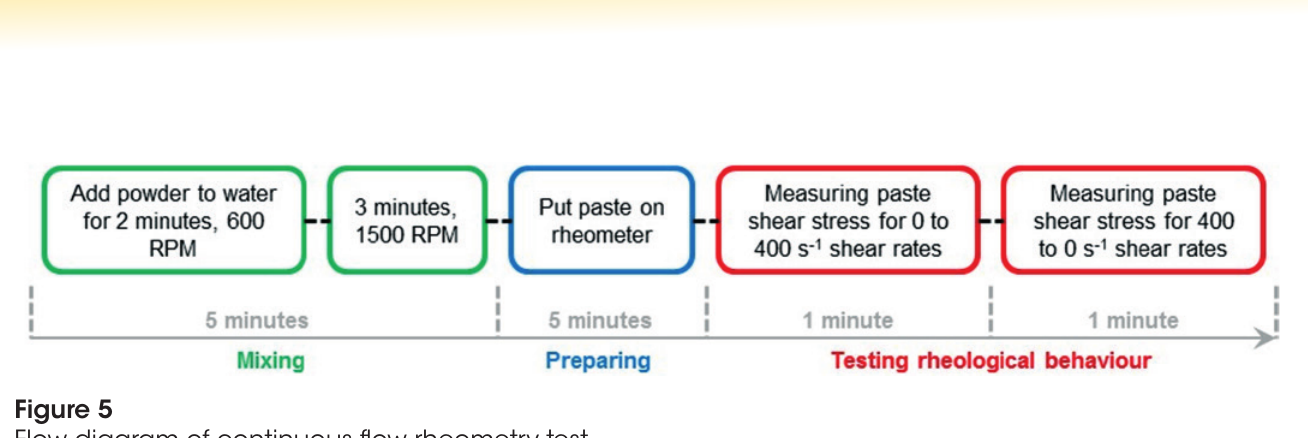
Flow diagram of continuous flow rheometry test